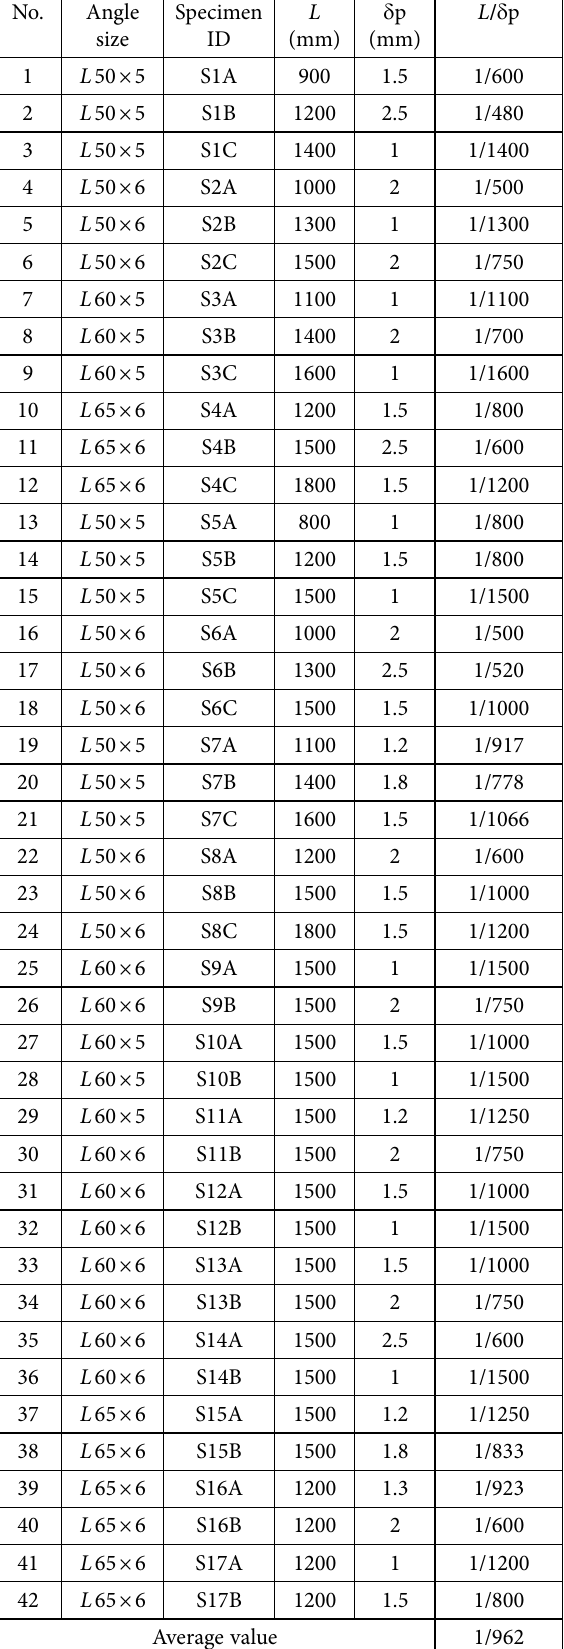
Table 2. Initial out-of-straightness of test specimens No.